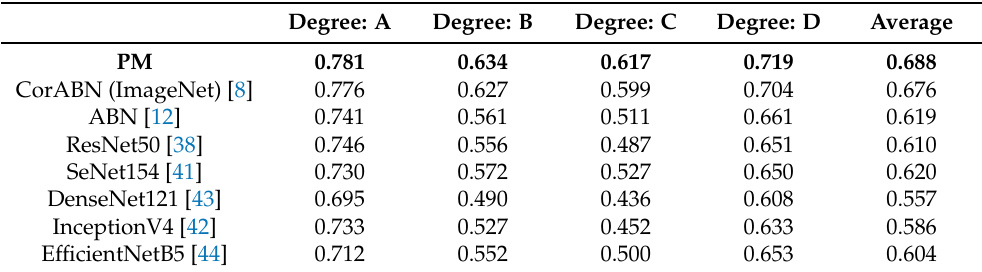
Table 6. F1-scores of PM and CMs in the distress type of crack. The best scores for each degree and the average are presented in